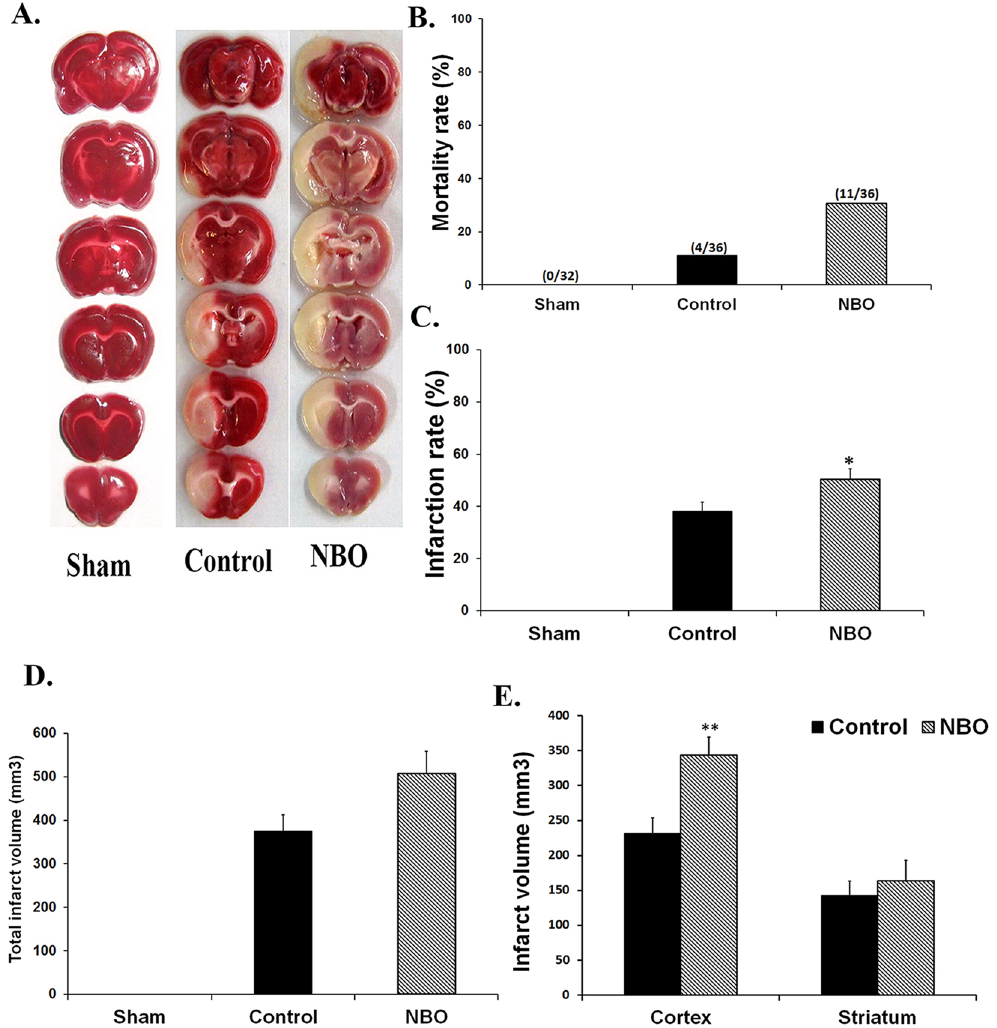
Figure 2. Effects of NBO treatment on ischemic brain injury. ( A ) Brain slices stained with TTC in the studied groups. Infarct region was illustrated with white color. ( B ) Mortality rate in the studied groups. ( C–E ) Infarct ratio, total, cortical, and striatal infarct sizes in the studied groups ( n = 6–8). Values are mean ± SEM. * P < 0.05, ** P < 0.01 compared to control